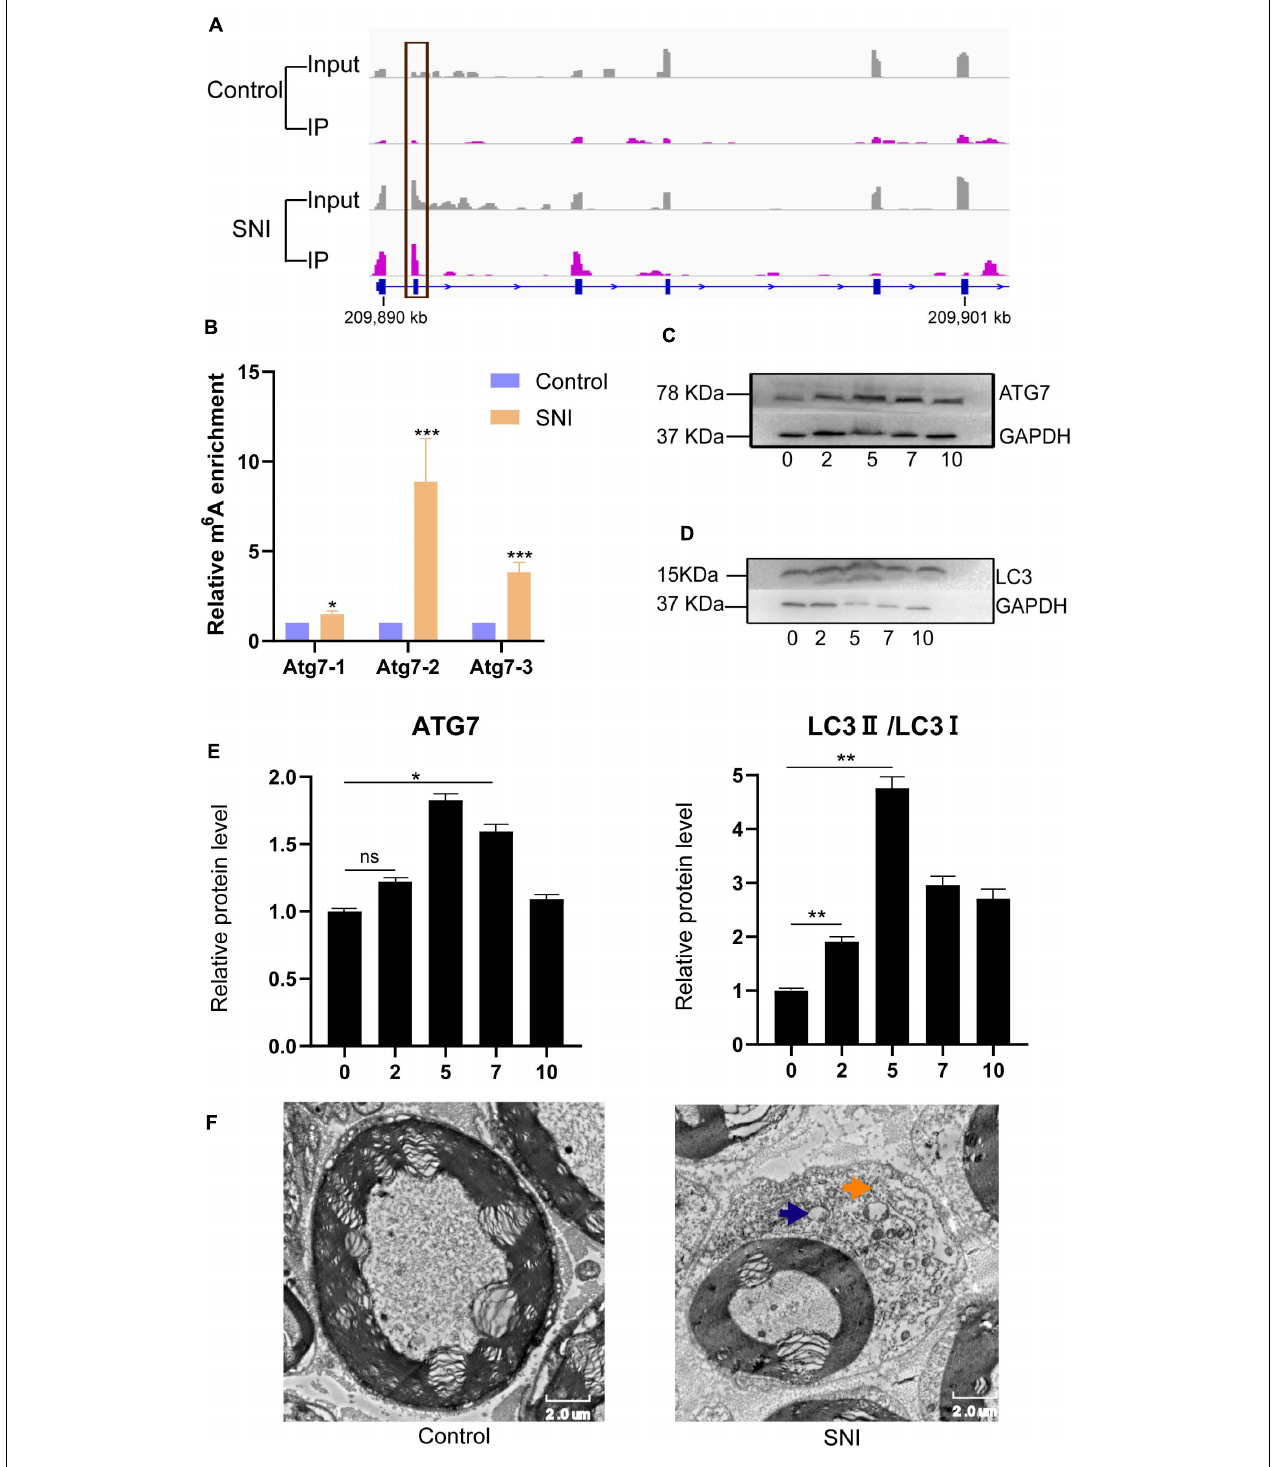
FIGURE 5 | The m6A methylation and protein expression of Atg7 gene are altered, and autophagy is activated following PNI. (A,B) Integrative genomics viewer and gene-specific m6A qPCR demonstrating the increased methylation of Atg7 gene after SNI. n = 3, via Student’s t test. (C) Upregulation of ATG7 protein level. n = 3, via Western blot analysis. (D) Expression level of the autophagy-related marker LC3 is increased. n = 3. (E) Quantification of Western blots for ATG7 and LC3II/LC3I. n = 3, via ANOVA and post hoc analysis. (F) Transmission electron microscopy showing autophagosome (yellow arrow) and lysosome (blue arrow) in the sciatic nerve tissues. “*,” “**,” and “***” indicate p < 0.05, p < 0.01, and p < 0.001,